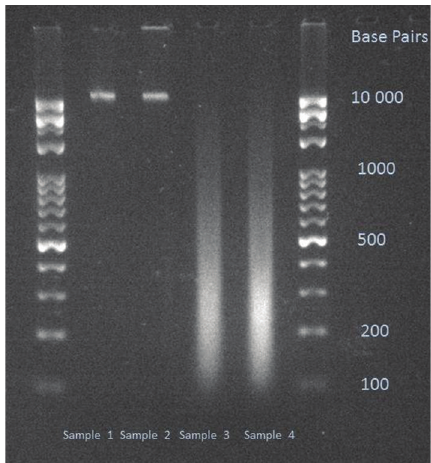
Figure 1: Electrophoretic gel image of the used DNA samples. Sample 1: nMnF DNA; Sample 2: MnF DNA; Sample 3: nMF DNA; Sample 4: MF DNA. 2% Tris-Borate-EDTA (TBE) gel.